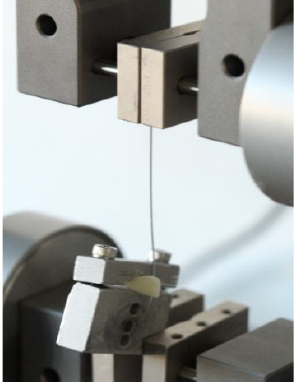
Figure 5. Half archwire and upper vise pulling the archwire.